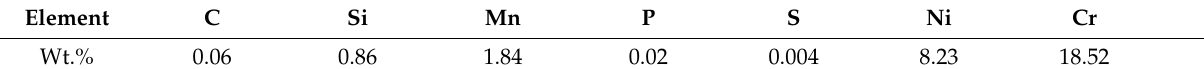
Table 2. Chemical composition of the 06Cr19Ni10 material.